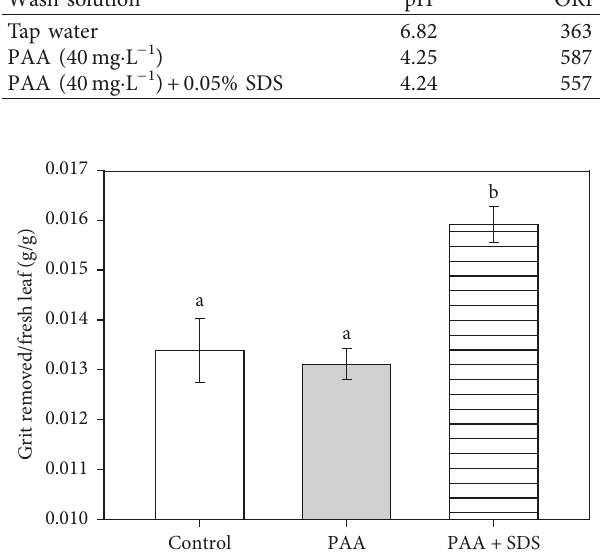
Figure 2: Grit removed g/g of baby spinach using washing solution treatments (control � tap water; 40ppm PAA; 0.05% sodium dodecyl sulphate). Error bars represent standard error of the mean ( n � 5). Different letters show significant differences at p < 0 .